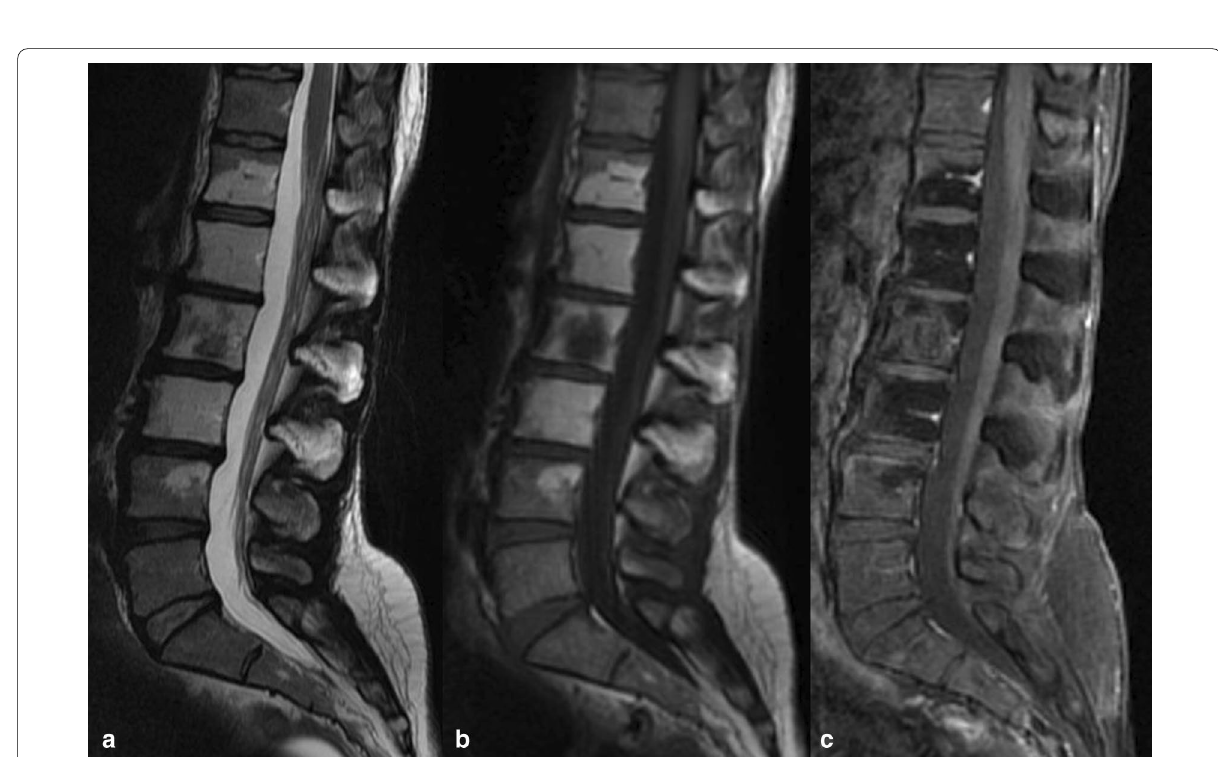
Fig. 25 A 46-year-old female patient with history of clear cell renal carcinoma. Sagittal T2-weighted ( a ), T1-weighted ( b ) and contrast-enhanced T1-weighted ( c ) images of the lumbar spine at the level of L2 a bone metastasis previously treated by thermoablation and radiotherapy. Note the bone marrow signal intensity of the vertebral elements in D12-L4 within the irradiation field, due to medullary depletion and fatty